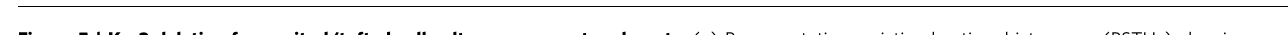
Figure 5 | Kcc2 deletion from mitral/tufted cells alters response to odorants. ( a ) Representative peristimulus time histograms (PSTHs) showing responses to different odorants recorded in mitral/tufted (M/T) cells (PSTHs are mean ± s.e.m., 10 trials). ( b , c ) Population firing rates averaged over